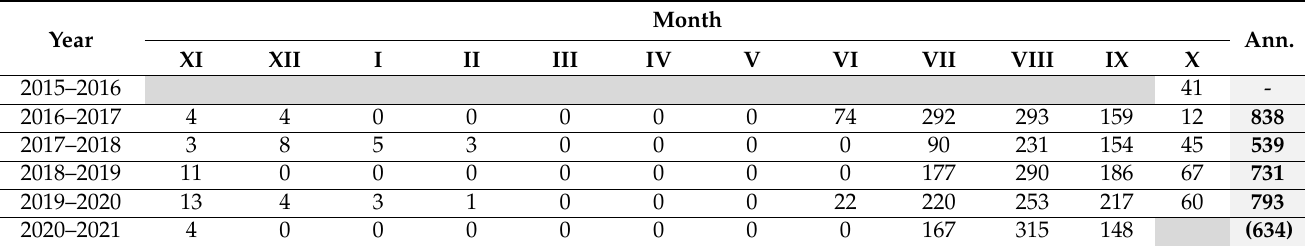
Table 9. Sums of positive daily temperatures at Snezhnika glacieret.